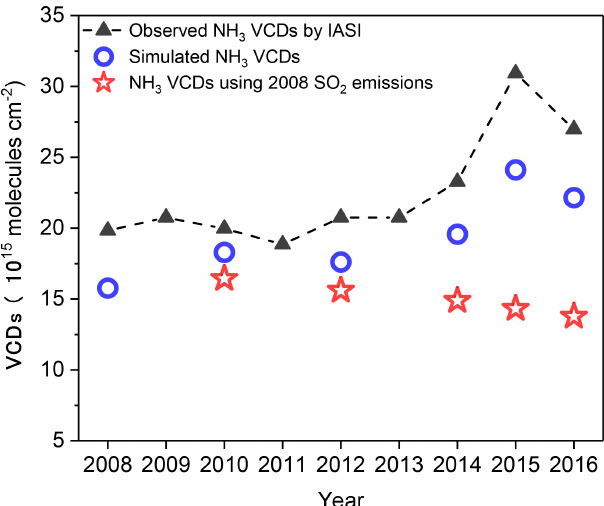
Figure 4. Trends in the annual averages of observed and simulated NH 3 columns over the North China Plain. The red stars denote the simulated NH 3 columns under the 2008 SO 2 emissions levels (i.e., Run_10_S08 to